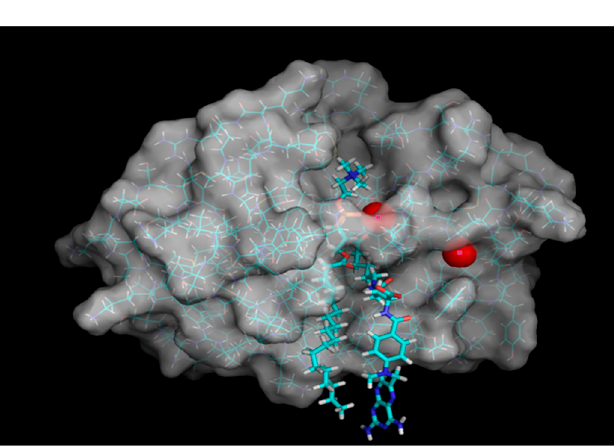
Figure 10. Bee venom PLA 2 binding pocket, demonstrating the binding of the PL-methotrexate complex. For clarity, only residues within 3.0 A of the Ca 2+ metal center are shown. The Ca 2+ ion is ligated to tryptophan, 2 glycine, and aspartate residues, as well as the phosphate group of the PL- methotrexate conjugate. Atoms are labeled as follows carbon (cyan), hydrogen (white), oxygen (red), nitrogen (blue), phosphate (gold), and calcium (yellow). The protein backbone is shown as a cyan ribbon. 4. Discussion